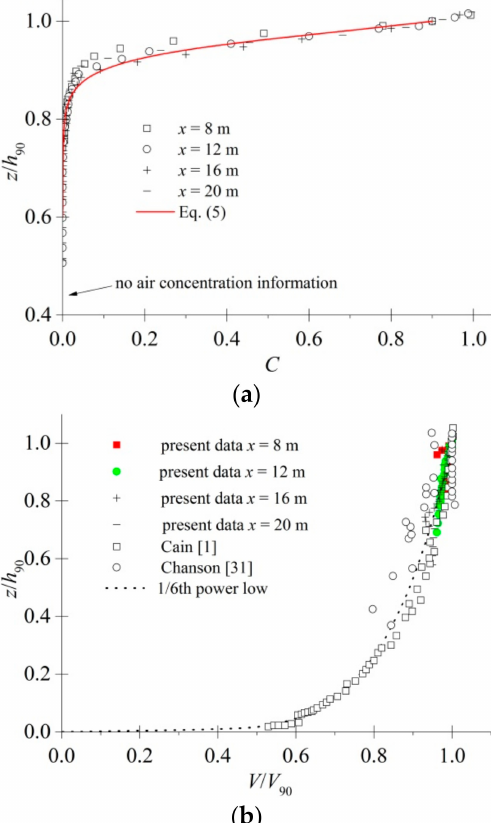
Figure 4. Distributions of air concentration ( a ) and velocity distribution ( b ) along the chute. Run: